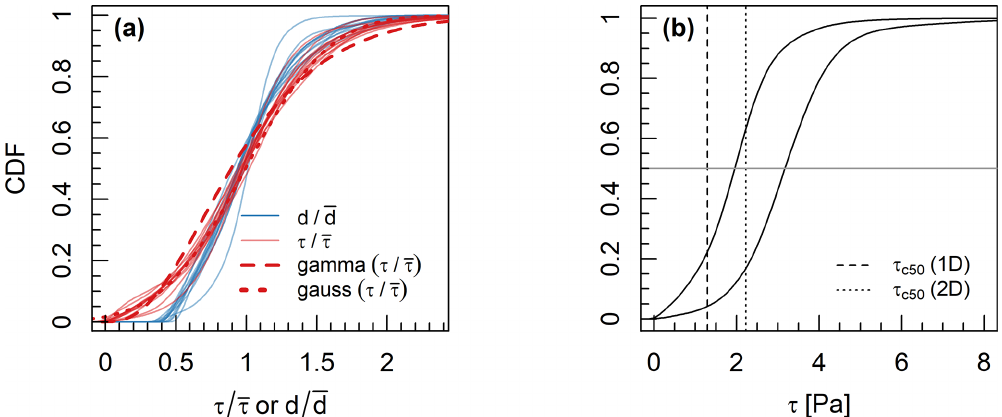
Figure 7. (a) Cumulative frequency distributions of mean-normalised modelled flow depth and shear stress at the end of each experimental phase, in which the upper end of the kernel density distribution has been truncated to approximately the 99th percentile to remove outliers. Note the absence of shallow depths ( d < 2 D 84 ). The average gamma distribution fit for the normalised shear stress distribution is included ( α = 3 . 30 ,β = 0 . 30), as is the average Gaussian fitted distribution ( σ = 0 . 47). (b) Cumulative frequency distribution of non-normalised modelled shear stresses in experimental phases with the highest (Exp1c(4)) and lowest (Exp1c(1)) mean shear stress (circled points in Fig. 6). Estimates of τ c50 using 1D and 2D approaches (B1 and B2, respectively) are indicated by dashed lines, and the horizontal line is the median shear stress, which closely corresponds to the